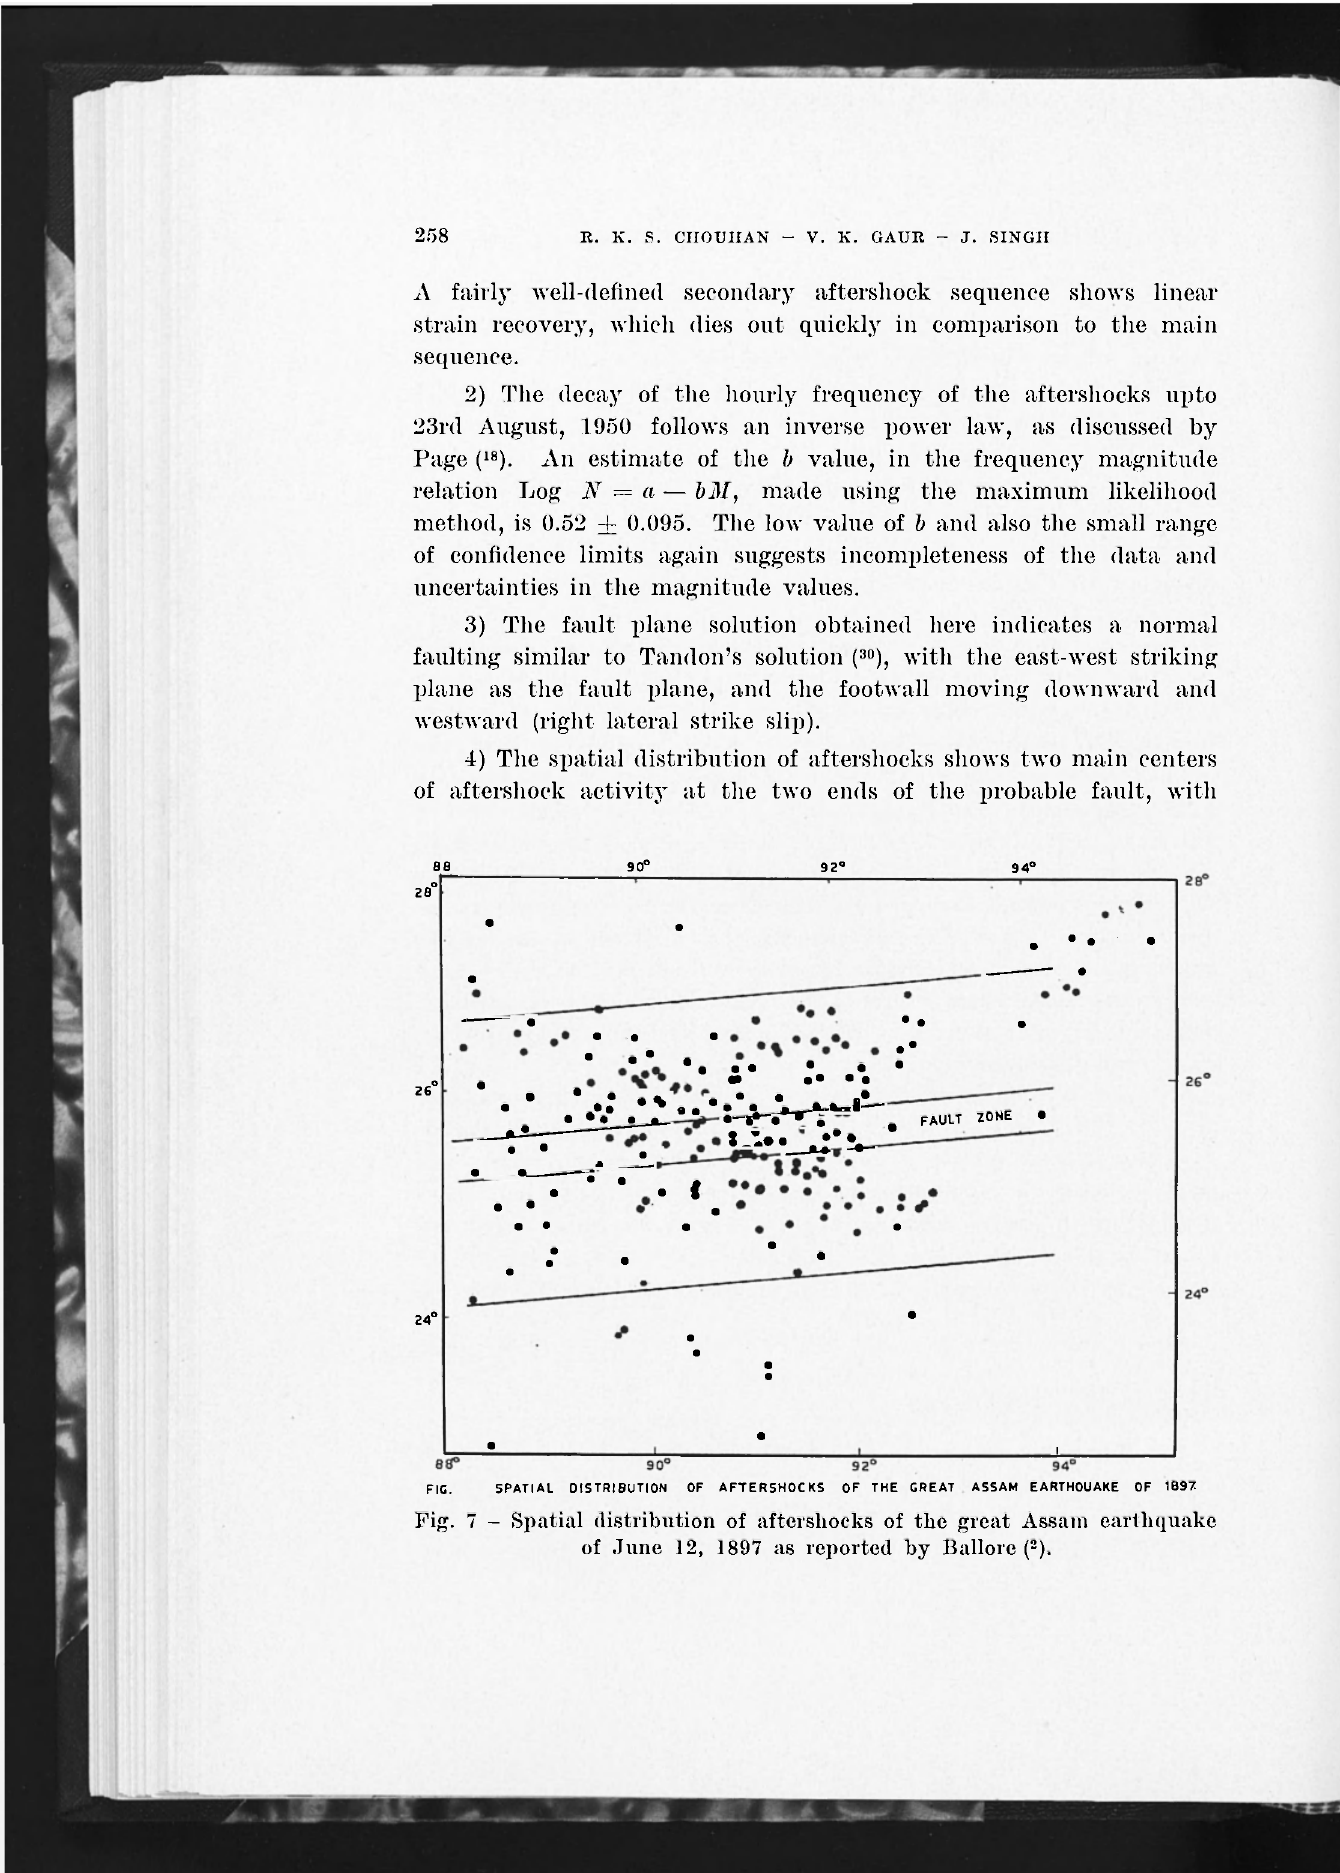
FIG. SPATIAL DISTRIBUTION OF AFTERSHOCKS OF THE GREAT ASSAM EARTHOUAKE OF 1897 Fig. 7 - Spatial distribution of aftershocks of the great Assam earthquake of June 12, 1897 as reported by Ballore ( 2